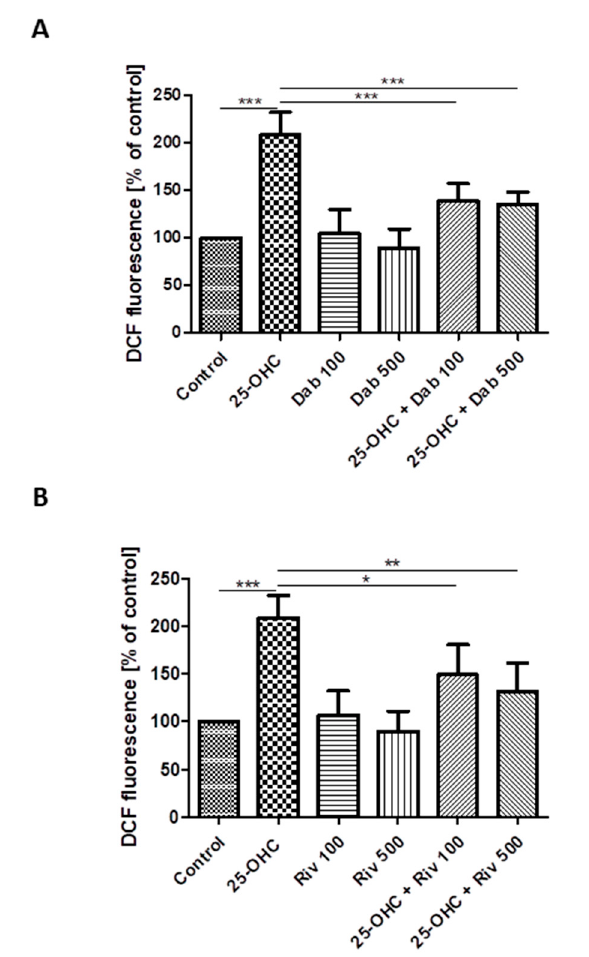
Figure 3. Changes in reactive oxygen species (DCF fluorescence) in HUVECs incubated with 25-hydroxycholesterol (10 µg/mL), ( A ) dabigatran (100 ng/mL and 500 ng/mL) and ( B ) rivaroxaban (100 ng/mL and 500 ng/mL). Mean ± SD calculated from nine individual experiments. Significant differences from negative controls are indicated by * p < 0.05; ** p < 0.01; *** p < 0.001. Statistical analysis was conducted using one-way ANOVA and post-hoc Tukey’s test.